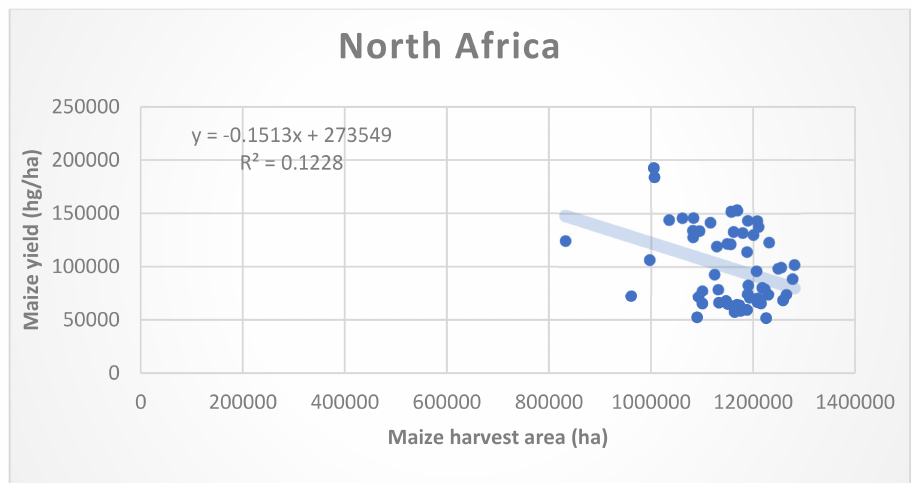
Figure 3. Scatter plot of the relationship between maize yield and harvest area in North Africa.